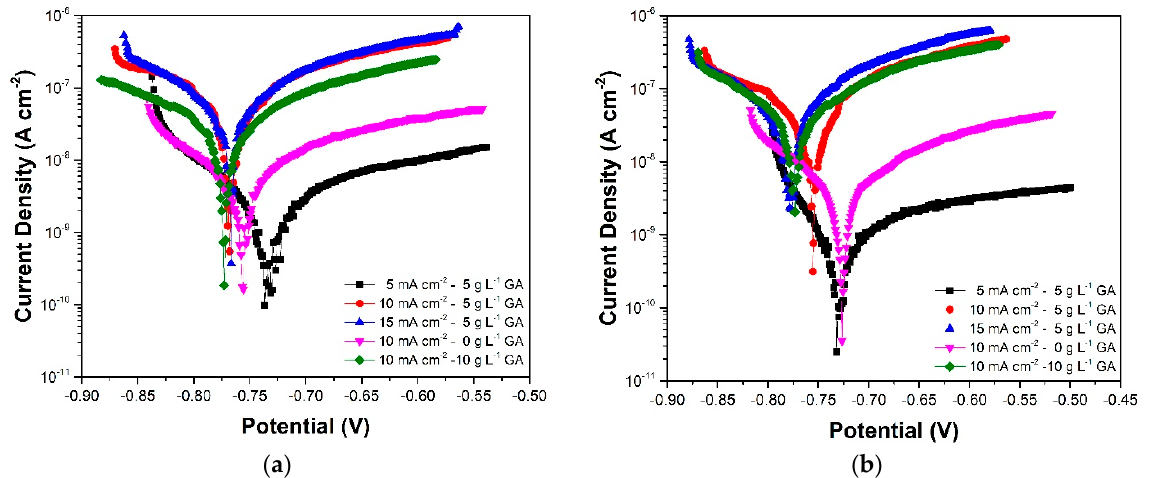
Figure 10. Tafel plots of the anodized aluminum samples acquired after ( a ) 15 days, and ( b ) 20 days of immersion in 3.5 wt.% NaCl.